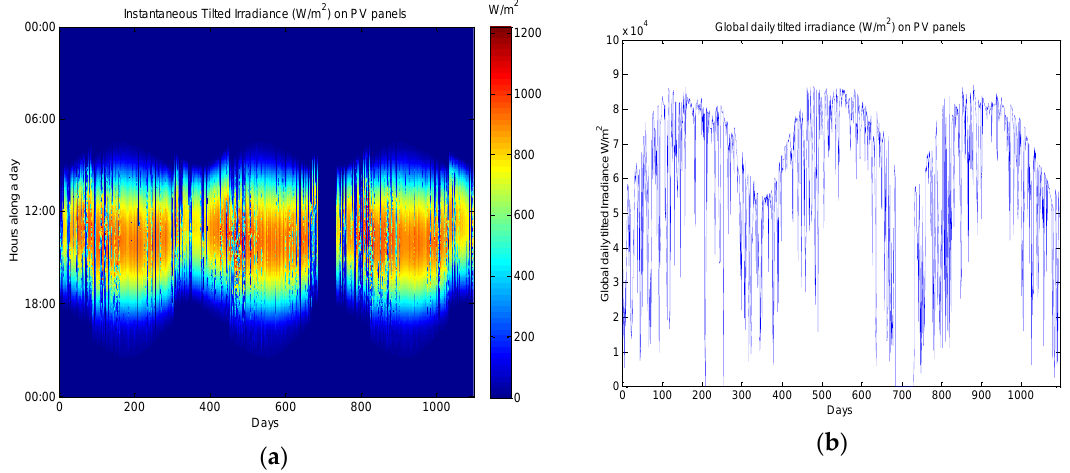
Figure 3. Tilted irradiance registered from 1 January 2011 to 31 December 2013: ( a ) instantaneous values, during 24 h a day; and ( b ) total daily values.